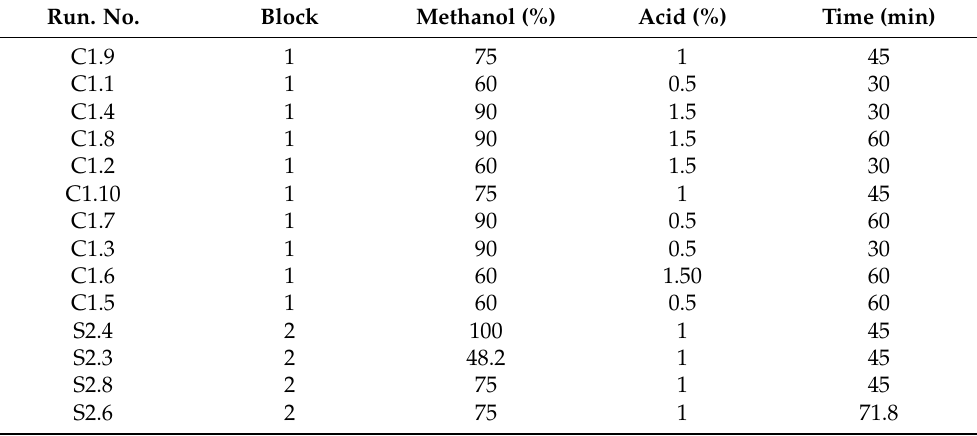
Table 1. Central composite design experiments used for the optimisation of the extraction conditions. Run.